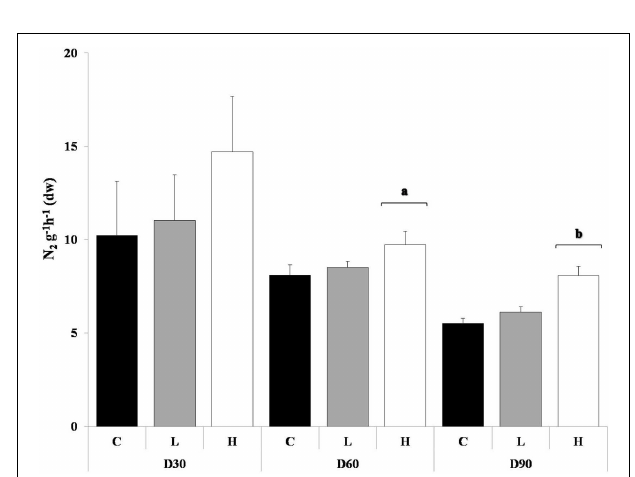
FIGURE 1 | Average EC 10 -values from the short-term toxicity tests with potential nitrification as endpoint, after 30, 60, and 90 days. The different treatments are shown as C, Control; L, Low; H, High. Values are shown as mean EC 10 log PAH concentration + 1 standard deviation ( n = 5 ). * indicates a significant difference to control.